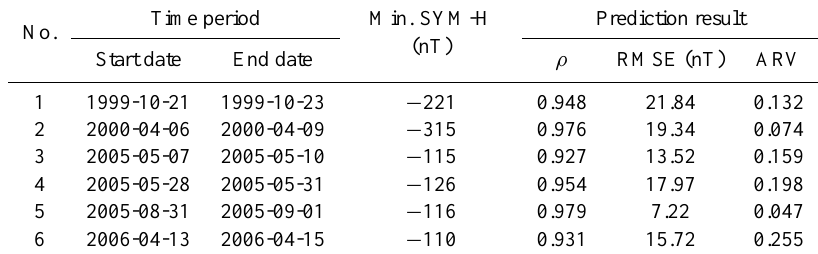
Table 2. Prediction performance by using ACE data for 6 test events.